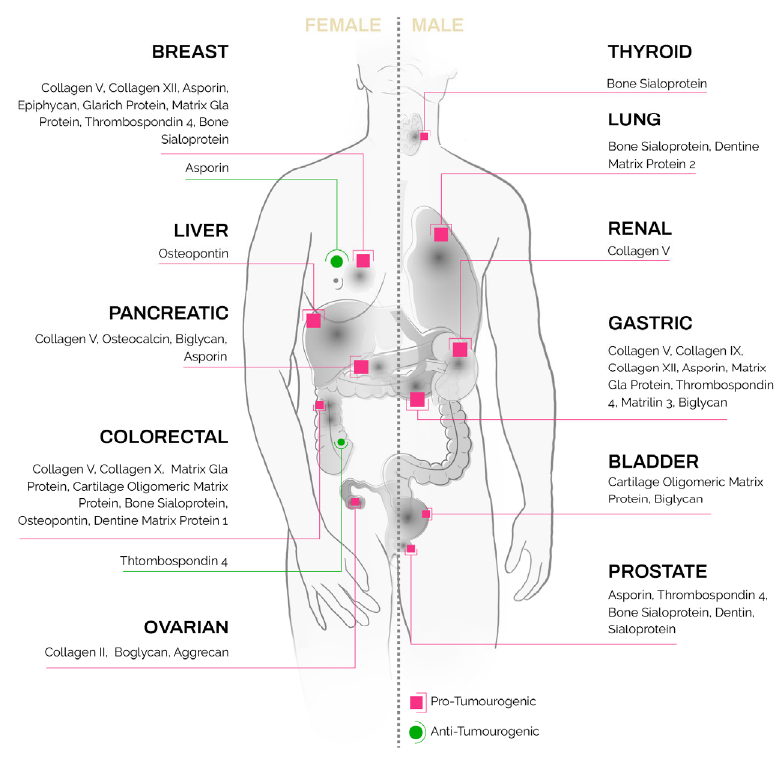
Figure 1. Bone ‐ and cartilage ‐ specific ECM proteins found in carcinoma subtypes. Figure 1. Bone- and cartilage-specific ECM proteins found in carcinoma